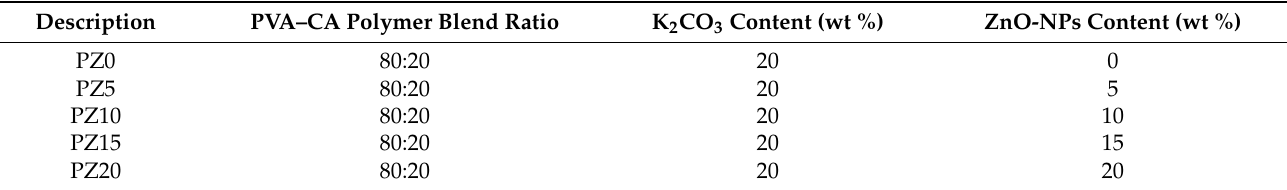
Table 1. Variations of ZnO-NPs in the PVA–CA–K 2 CO 3 /ZnO SPE composites.